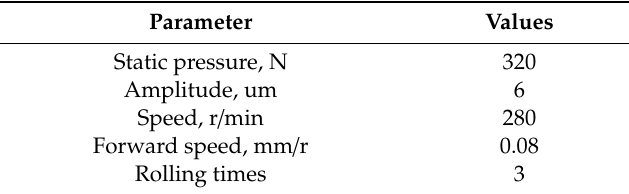
Table 4. Ultrasonic surface rolling processing